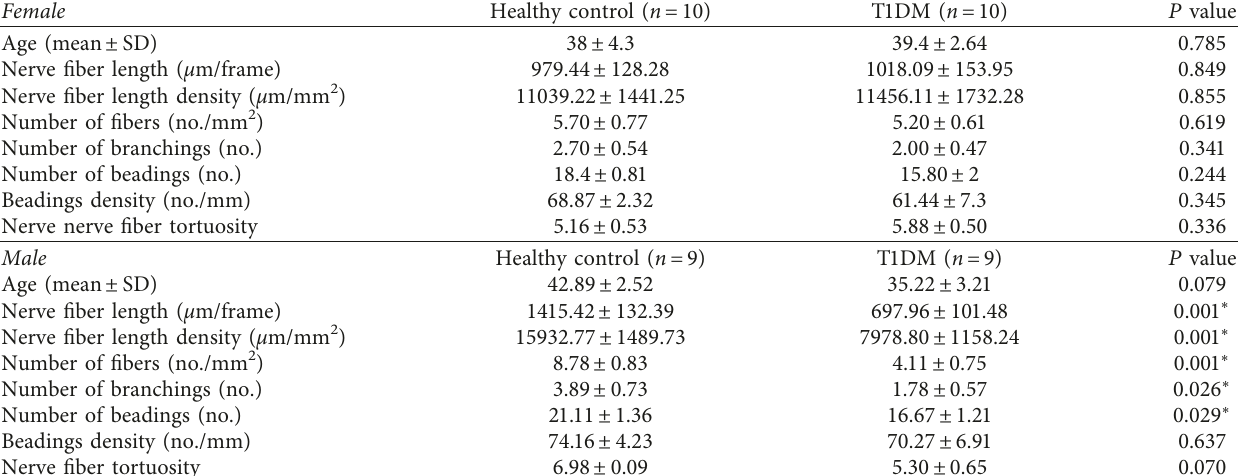
Table 4: Comparison between the healthy control and T1DM patients divided by